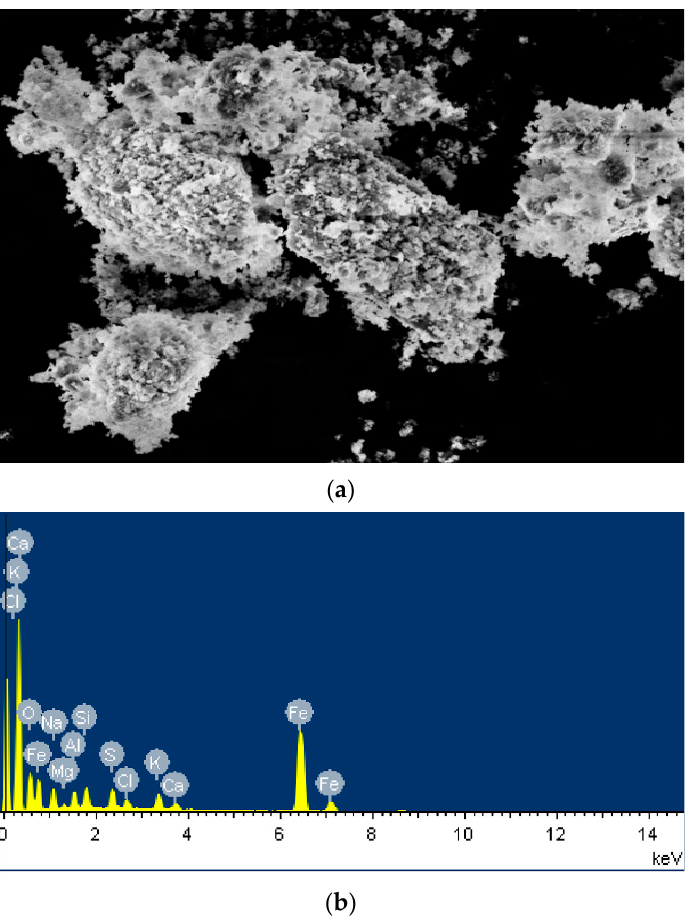
Figure 4. SEM morphology of blast furnace dust.